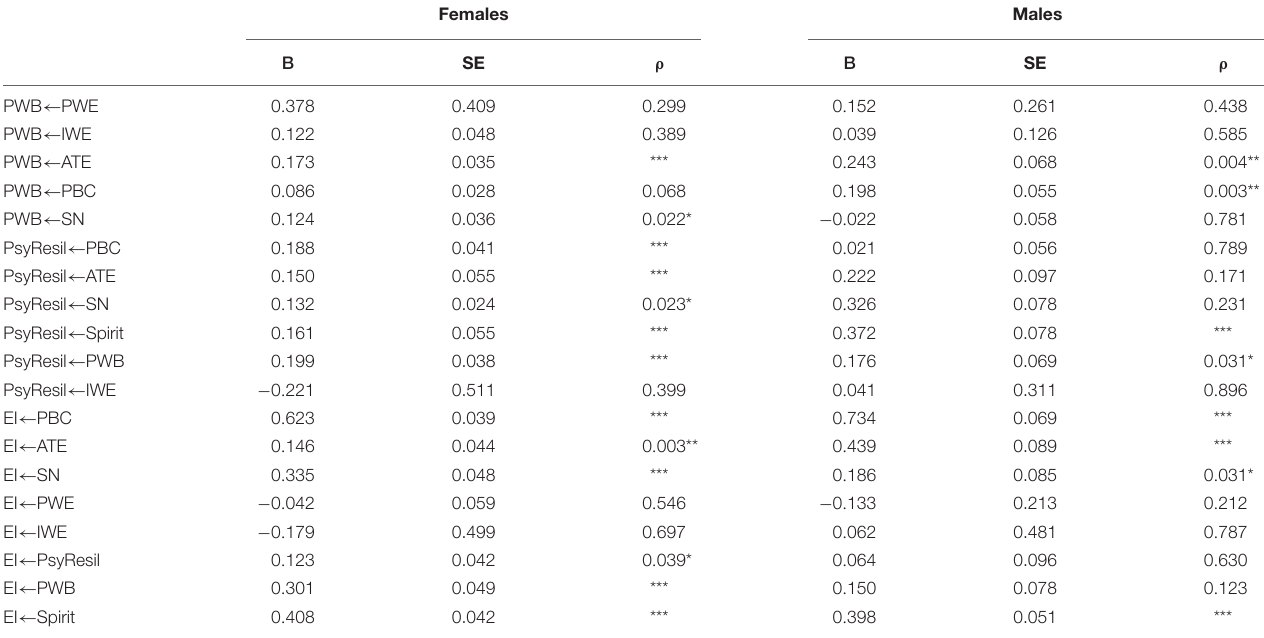
TABLE 4 | Regression weights by gender.